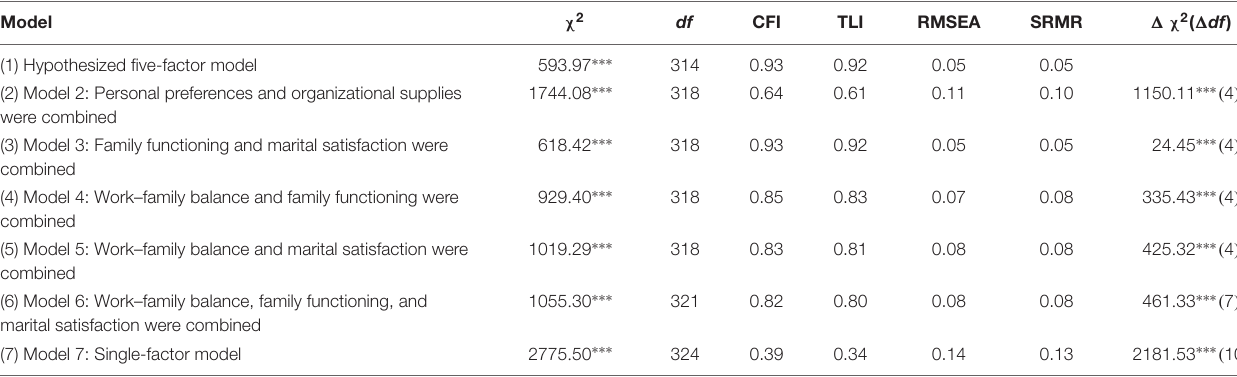
TABLE 2 | Model fit results for confirmatory factor analysis.